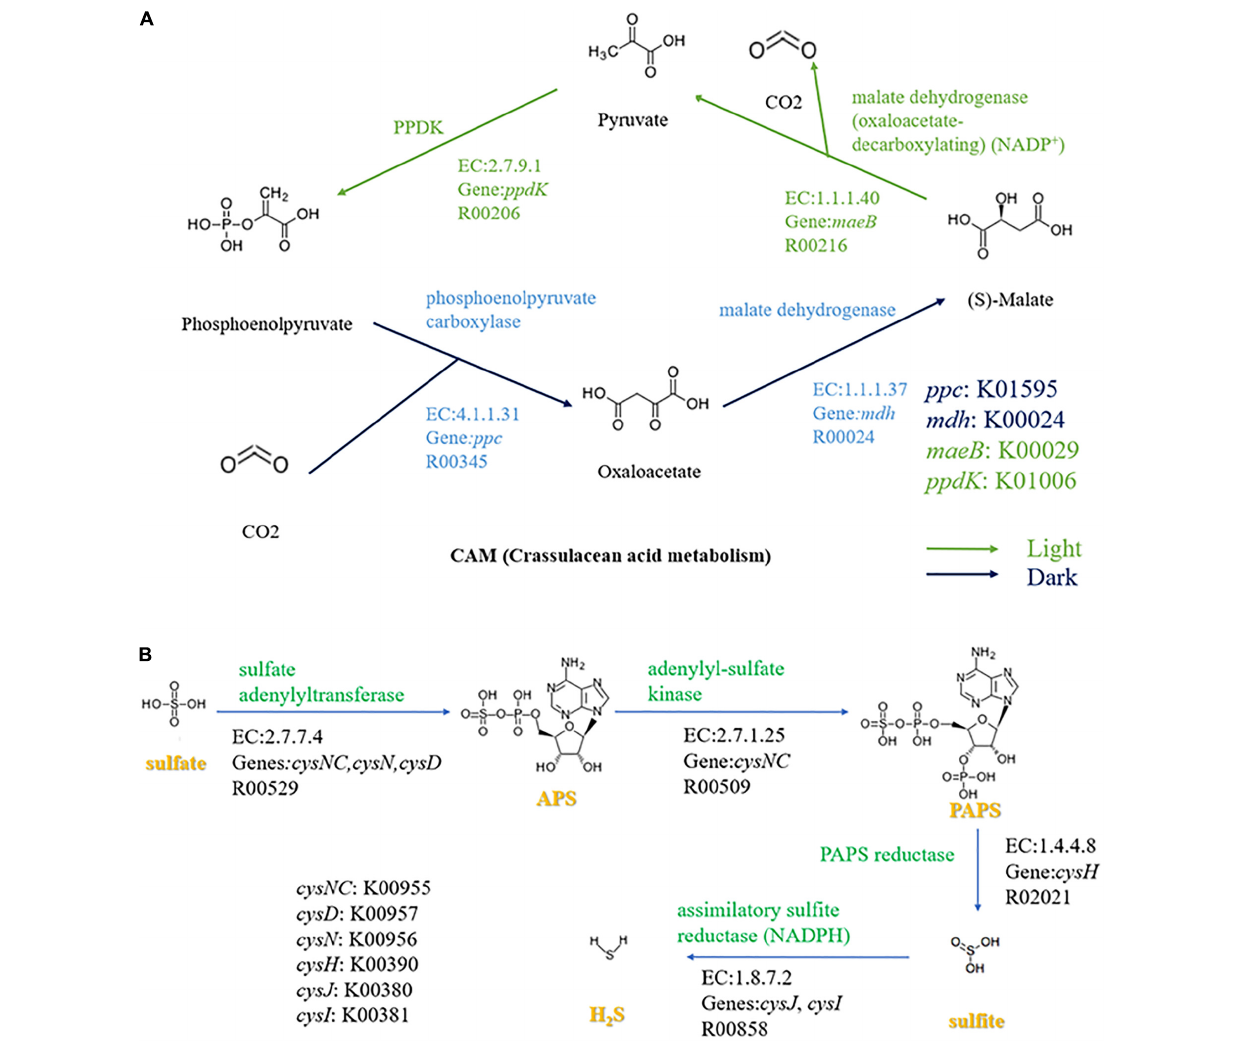
Frontiers in Marine Science |